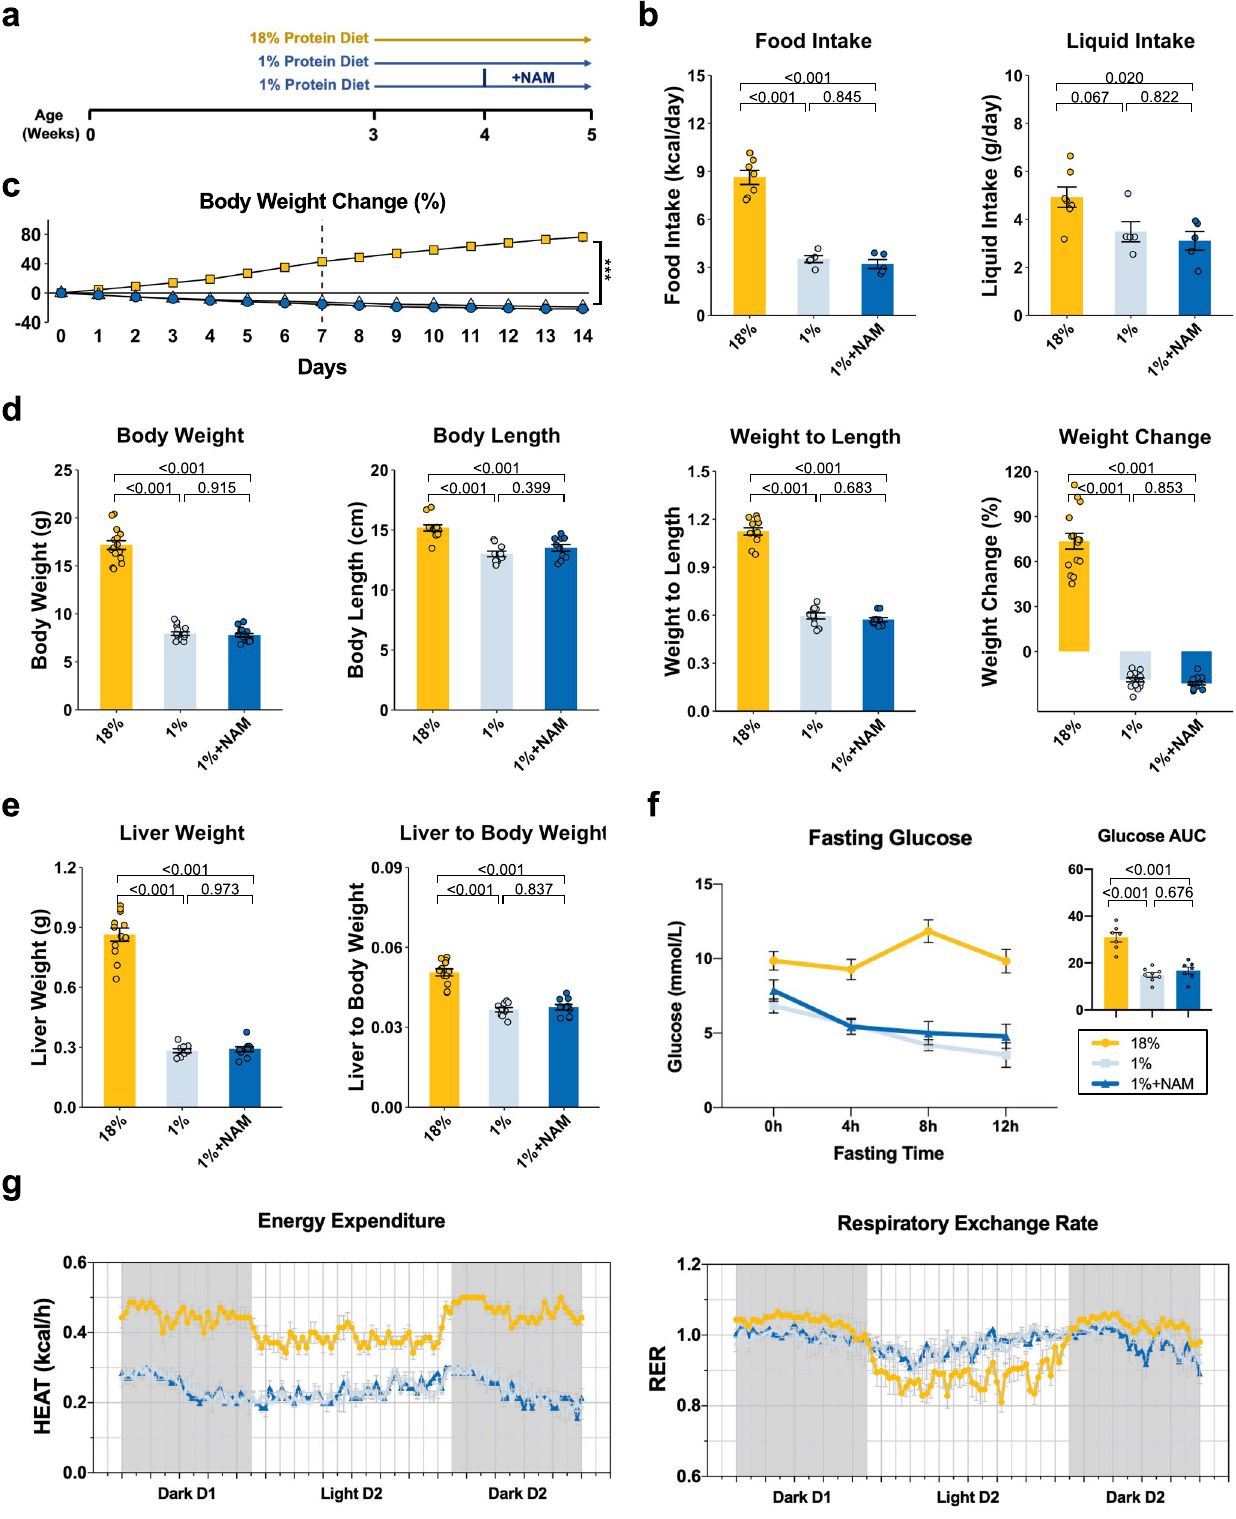
e Liverweightandliverweighttobodyweightratio( n =12for18%; n =10for1and1% +NAM). f Fasting glucose levels ( n =7 for 18%; n =8 for 1%; n =7 for 1%+NAM). AUC: area under the curve. g Energy expenditure and respiratory exchange rate (RER) of the entire animal. ( n =7 for 18%; n =6 for 1%; n =7 for 1%+NAM). One-way ANOVA followed by Tukey ’ s post hoc test. Data are shown as the